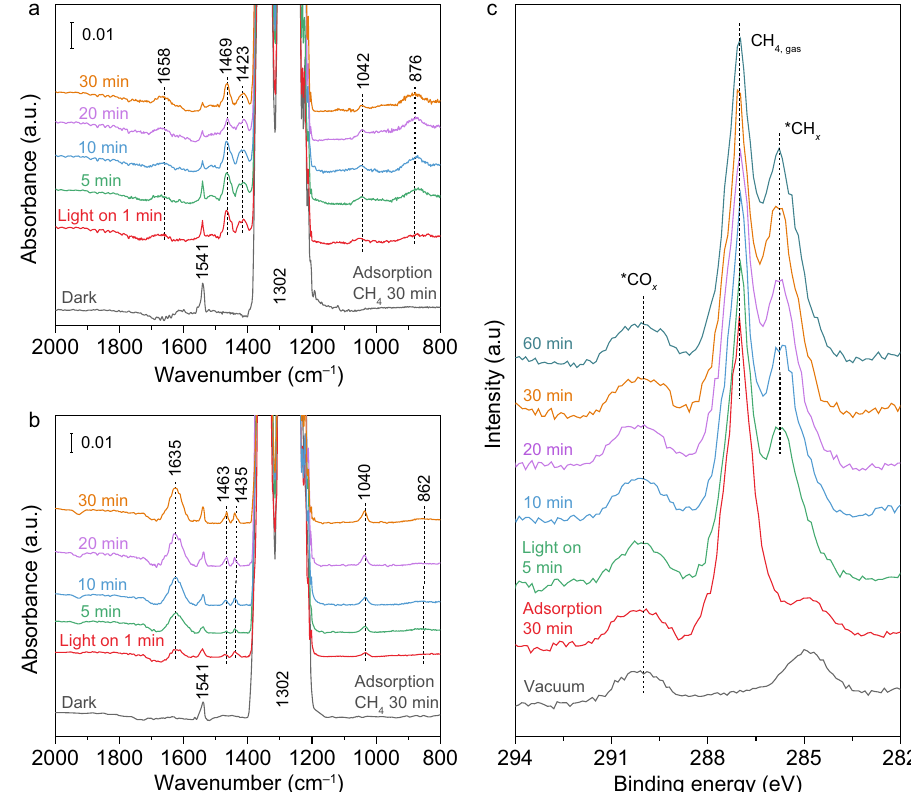
Fig. 3 Intermediates detection for photocatalytic NOCM. a , b In situ DRIFTS spectra for photocatalytic NOCM over Pd 1 /TiO 2 ( a ) and Pd n /TiO 2 ( b ). c In situ high-resolution C 1 s XPS spectra of Pd 1 /TiO 2 catalyst with different light illumination time in 45 Pa CH 4 .